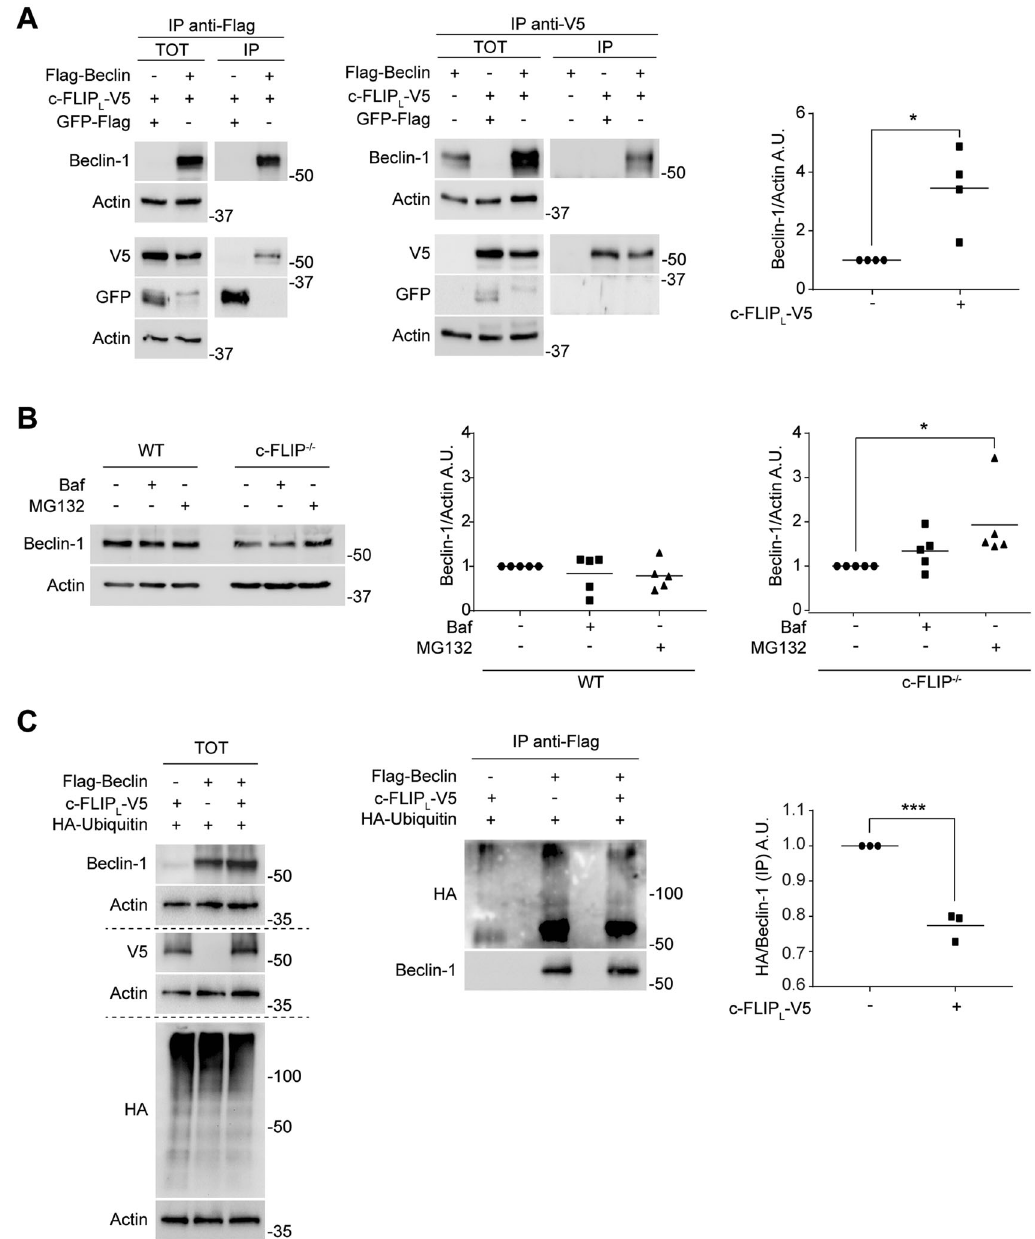
Fig. 4 c-FLIP L interacts with Beclin-1 and affects Beclin-1 degradation. A Hek293 cells were transfected to overexpress c-FLIP (c-FLIP L -V5) and Beclin-1 (Flag-Beclin). α -Flag-beads were used to immunoprecipitate Beclin-1 and an α -V5 antibody was used to immunoprecipitate c-FLIP. GFP-Flag was transfected to verify the speci fi city of the interaction. The result was detected by western blotting. β -Actin was used as a loading control. The graph quanti fi es Beclin-1 expression levels in correlation with c-FLIP overexpression. Data shown are representative of at least three individual experiments. * p < 0.05 determined with two-tailed Student ’ s t -test. B WT and c-FLIP − / − MEFs were treated with either ba fi lomycin (Baf) (100 nM) or MG132 (10 μ M) for 4 h and Beclin-1 protein expression was then analysed by western blotting. Data shown are representative of at least three individual experiments. β -Actin was used as a loading control. * p < 0.05 determined by one-way ANOVA. C Hek293 cells were transfected to overexpress c-FLIP (c-FLIP L -V5), Beclin-1 (Flag-Beclin) and ubiquitin (HA-Ubiquitin). α -Flag-beads were used to immunoprecipitate Beclin-1. Protein signals were evaluated via western blotting and β -Actin was used as a loading control. Ubiquitination of Beclin-1 (HA/Beclin-1) was quanti fi ed in the graph. Data shown are representative of three individual experiments. *** p < 0.001 determined with two-tailed Student ’ s t compared to WT in basal conditions as well (Fig. 3 and of c-FLIP. Selective binding of Atg14 to the core nucleation Supplementary Fig. S3). complex (Beclin-1-Vps34-Vps15) mediates its presence at the ER in c-FLIP is a scaffold protein devoid of any catalytic activity [10], the autophagosomes nucleation step [37]. We found that the which suggests that it may interact with the proteins involved in levels of all the three markers increase after autophagy induction the autophagosome nucleation phase. All factors that participate in WT MEFs, as expected, but not in c-FLIP − / − cells. We also found to this step of the autophagic process are highly regulated and that all these proteins are downregulated in c-FLIP − / − cells